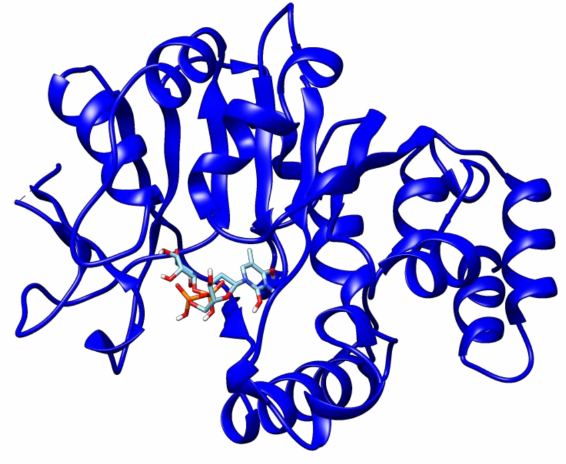
Figure 5. The docked complex of 2 (cid:48) -deoxy-thymidine-beta- l -rhamnose and glucose-1- phosphate thymidylyltransferase.